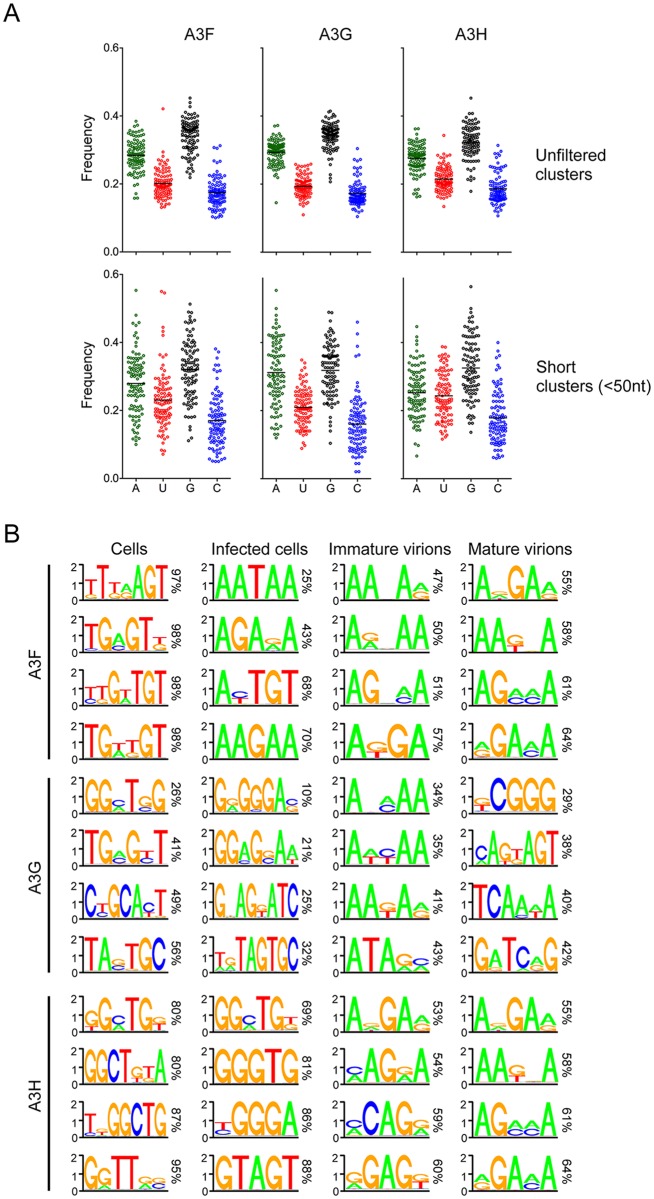
Nucleotide composition of preferred A3 protein binding sites.(A) The 100 PARalyzer-generated clusters in mRNAs with the greatest number of total associated reads in A3 CLIP experiments were inspected and the fraction the sequence composed of each of the four nucleotides was plotted (top). PARalyzer-generated clusters were filtered according to size (<50 nucleotides) and the clusters with the greatest number of total associated reads in A3 CLIP experiments were inspected and the fraction the sequence composed of each of the four nucleotides was plotted (bottom). (B) Deoxyribonucleotide sequence motifs identified by cERMIT in CLIP-seq cDNA libraries as most frequently present in A3-bound RNA in uninfected cells, infected cells and in immature and mature purified virions. Cumulative percentages of clusters containing the motifs are indicated.